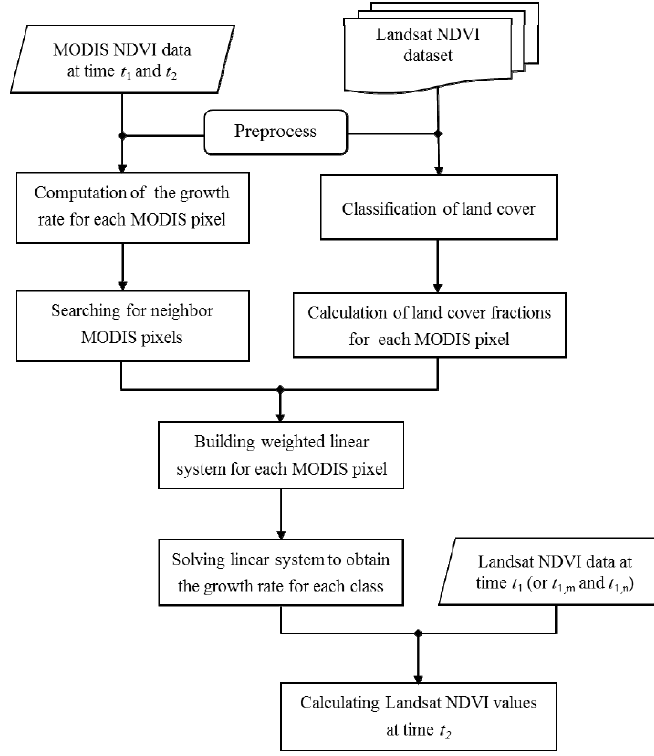
Figure 2. The flowchart of NDVI Linear Mixing Growth model